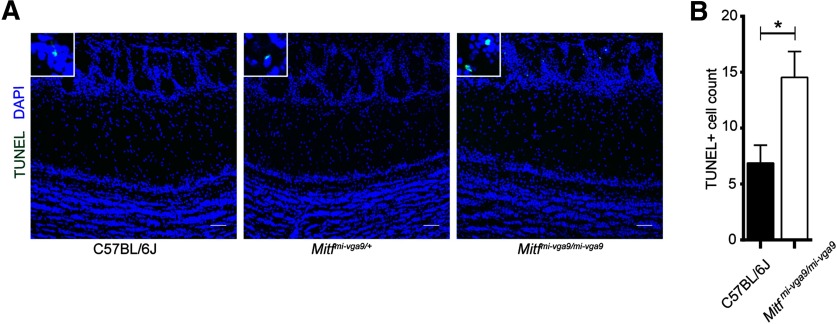
Increase in apoptosis in OBs of Mitfmi-vga9/mi-vga9 mice. A, TUNEL staining of sections of OBs of the indicated genotypes, showing localization of apoptotic cells. B, The number of apoptotic cells of OB of wild-type and Mitfmi-vga9/mi-vga9 mice. N = 9 per genotype. The values on the graphs are mean ± SEM DAPI nuclear staining is shown in blue. Scale bars: 50 μm; p values were calculated using two-tailed unpaired Student’s t test; *p < 0.05.